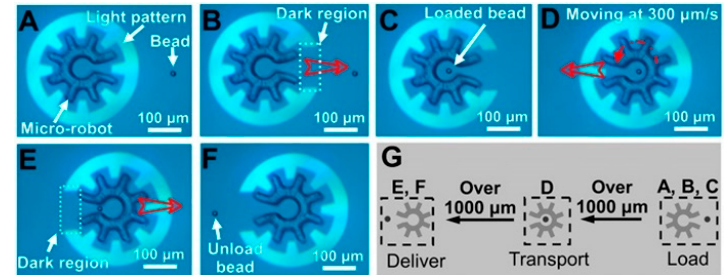
Figure 8. A series of OEK-based robotic micromanipulations. ( A ) A fully enclosed microrobot; ( B ) the load mode of a partially enclosed microrobot; ( C ) the partially enclosed microrobot loaded one bead of interest; ( D ) the fully enclosed microrobot transported the bead; ( E ) the partially enclosed microrobot delivered the bead; ( F ) the bead was unloaded; ( G ) schematic illustration of the “load,” “transport,” and “deliver” micromanipulations (reproduced from Ref.